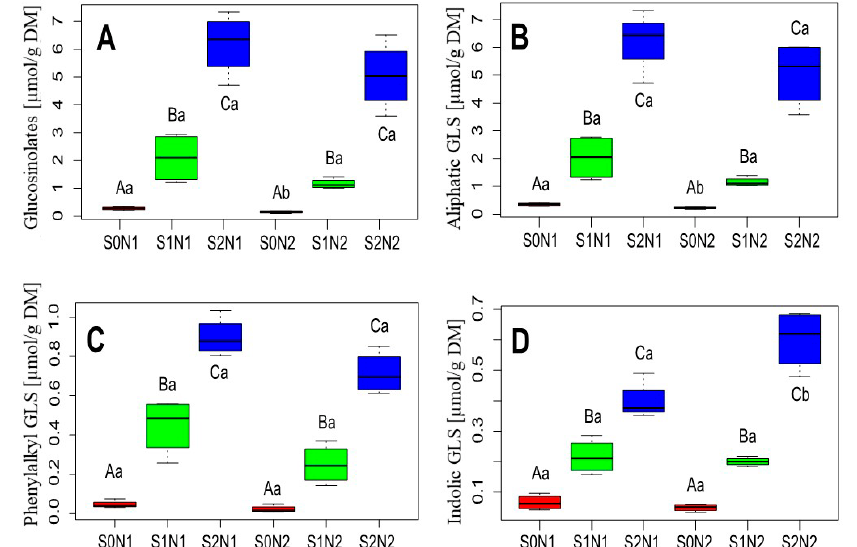
Fig. 3: The total concentration of glucosinolates (GLS) detected in pak choi (A) and the concentrations after classification into aliphatic (B), phenylalkyl (C), and indolic glucosinolates (D). Lower- and uppercase letters indicate significantdifference (p<0.05) between means owing to the effect of N and S sup - ply respectively, S0 = 0 g S, S1 = 0.06 g S, S2 = 0.3 g S, N1 = 0.75 g N, N2 = 1.5 g